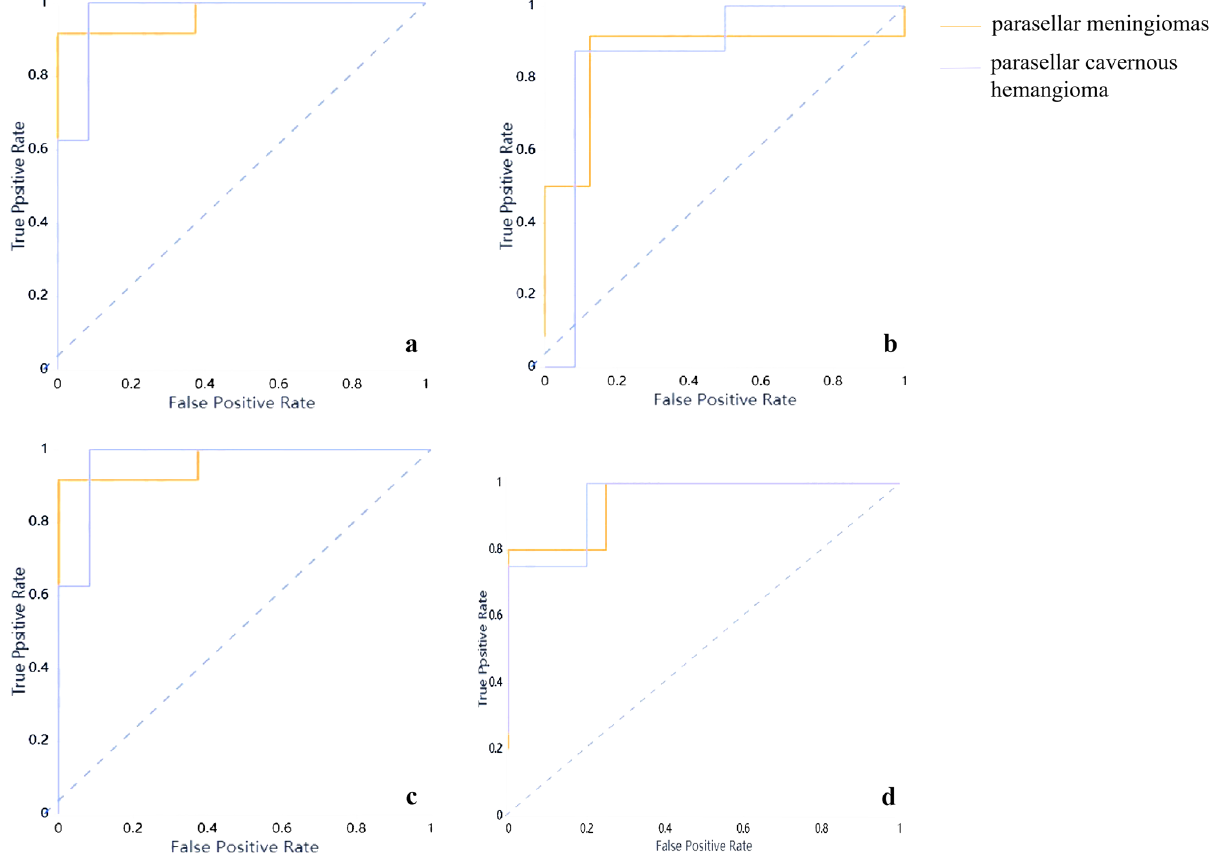
Figure 6. ROC curves for the optimal classifier. ( a ) ROC curve for KNN model based on T 2 WI with AUC = 0.93; ( b ) ROC curve for SVM model based on T 2 WI with AUC = 0.88; ( c ) ROC curve for KNN model based on ADC maps with AUC = 0.83; ( d ) ROC curve for SVM model based on ADC maps with AUC =